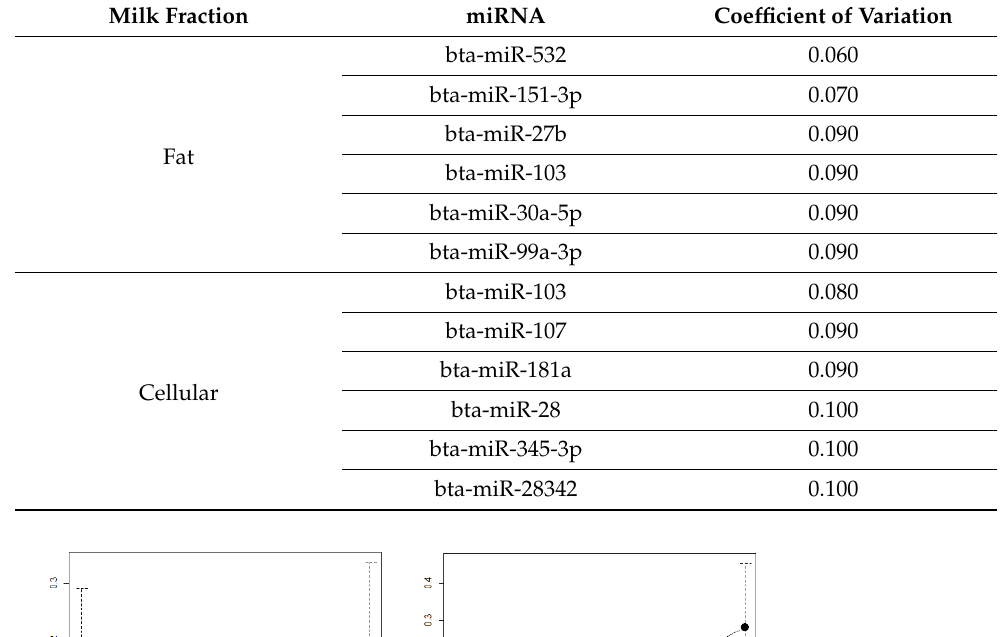
Table 7. Ranking of the most stable miRNAs according to the coefficient of variation. Milk Fraction